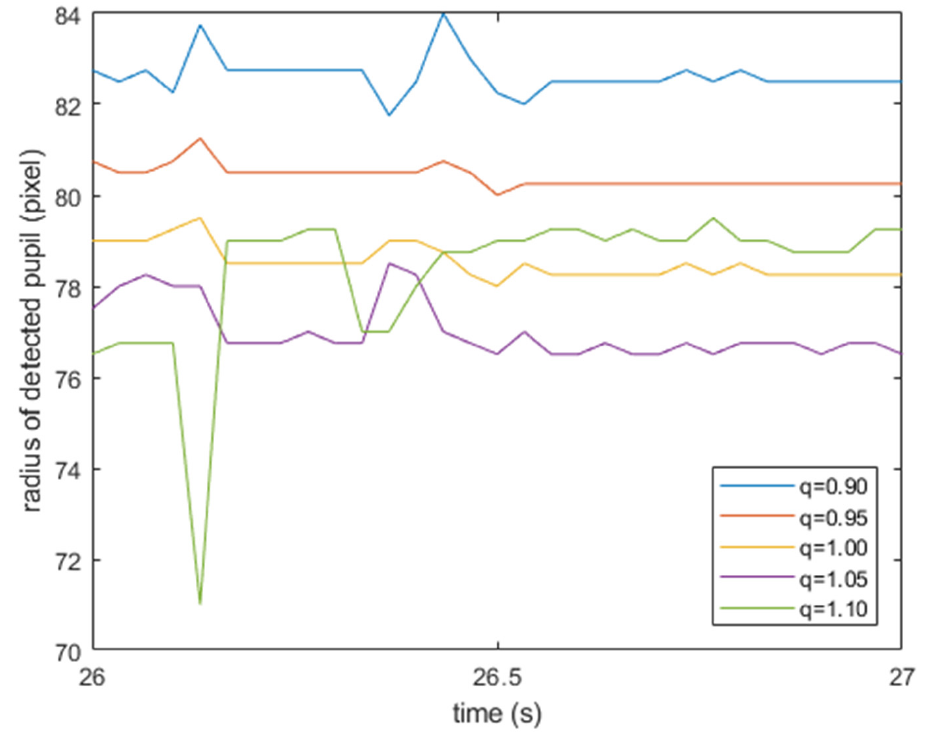
Figure 5. Sample of r ( t ) for varying values of q .